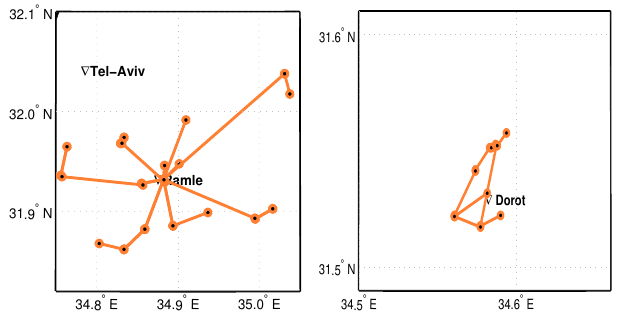
Figure 13. ML distribution for two different coordinates. Left: Fig.13. MLdistributionfortwodifferentcoordinates. Left: Ramlecoordinate,inanareaofabout400 km 2 ,for Ramle coordinate in an area of about 400km 2 for 30 ML pro- 30 ML provided by Pelephone Ltd. Right: Dorot coordinate in an area of about 150 km 2 , for 12 ML provided vided by Pelephone Ltd. Right: Dorot coordinate in an area of about byCellcomltd. 150km 2 for 12 ML provided by Cellcom Ltd.